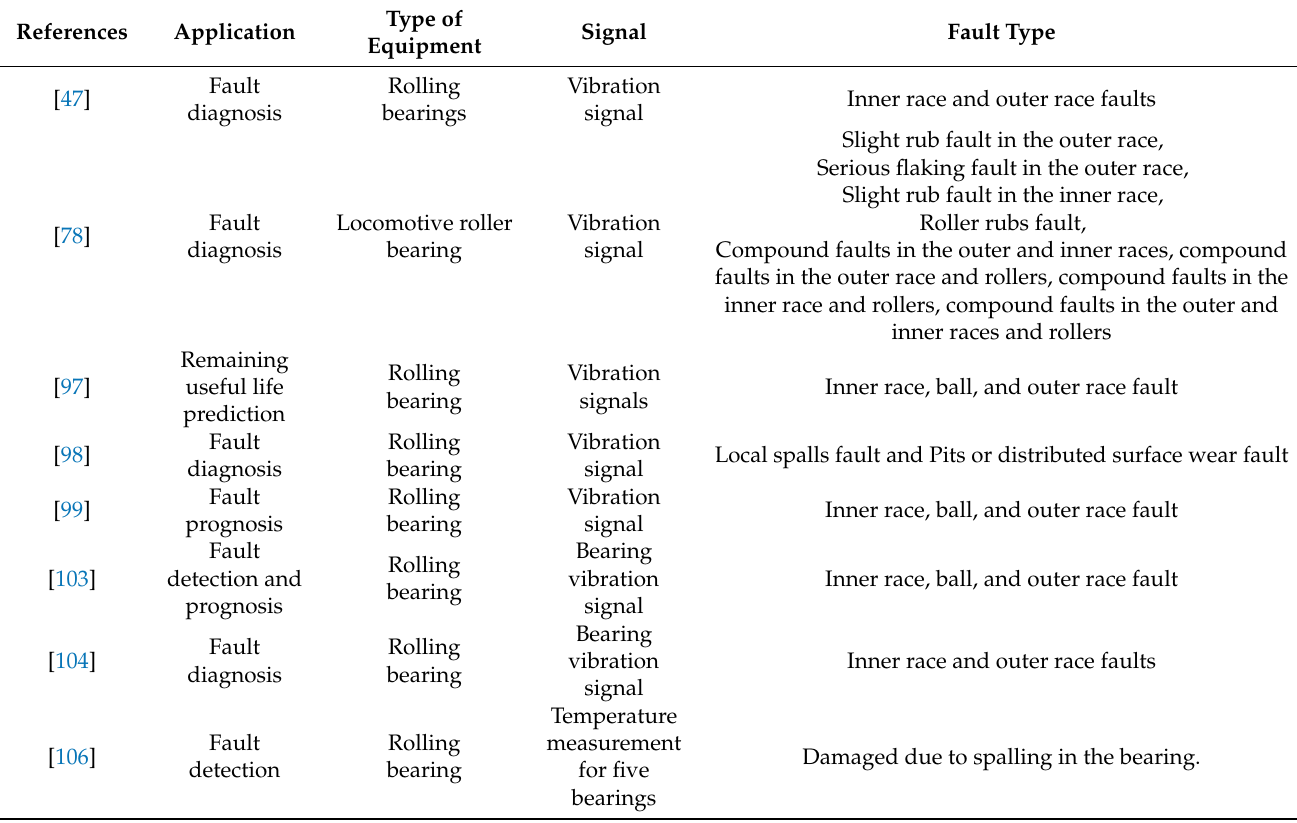
Table 12. Bearing condition monitoring using artificial neural